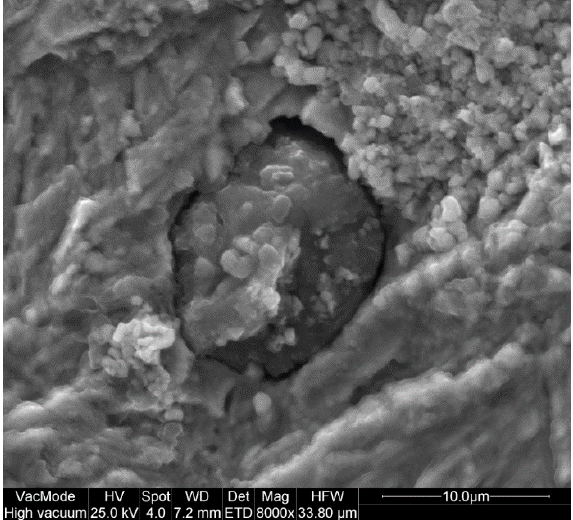
Figure 6. Internal inclusion crack initiation of the large specimen ( σ a = 520 MPa, N f = 4.25 × 10 7 ).